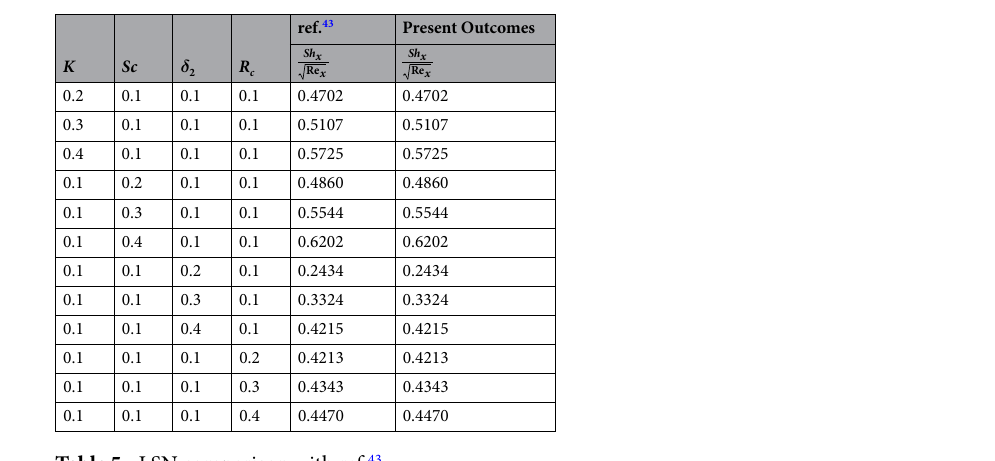
Table 5. LSN comparison with ref. 43 .